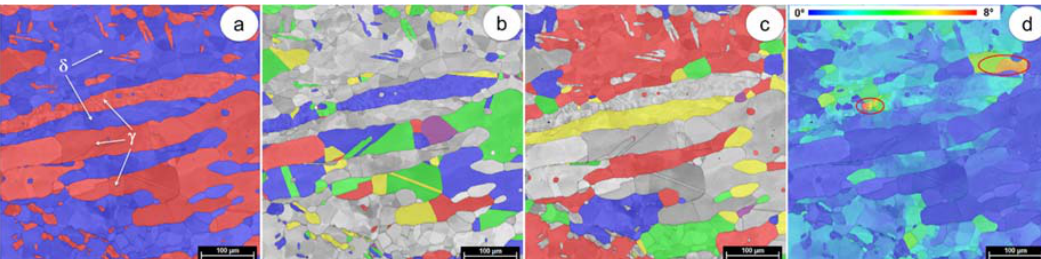
Figure 2. SEM-EBSD composite images for the UNS 32750 alloy in the initial structural state (sample 0): ( a ) phase distribution ( γ -phase in red and δ -phase in blue); ( b ) grain size, shape and distribution for γ -phase; ( c ) grain size, shape and distribution for δ -phase; and, ( d ) Grain Reference Orientation Deviation (GROD) map distribution for both γ and δ